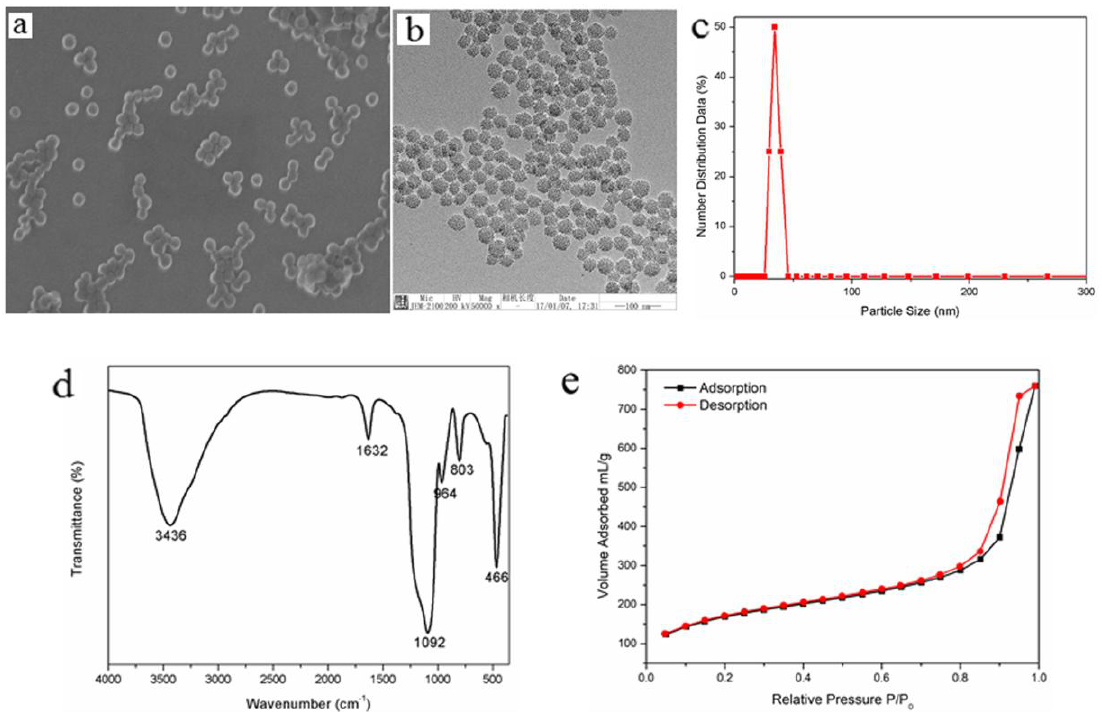
Figure 2. Scanning electron microscopy (SEM) image ( a ), transmission electron microscopy (TEM) image ( b ), particle size distribution ( c ), Fourier-transform infrared (FT-IR) spectra ( d ), and nitrogen adsorption-desorption isotherm of the as-prepared monodispersed mesoporous silica nanoparticles (MSNs) ( e